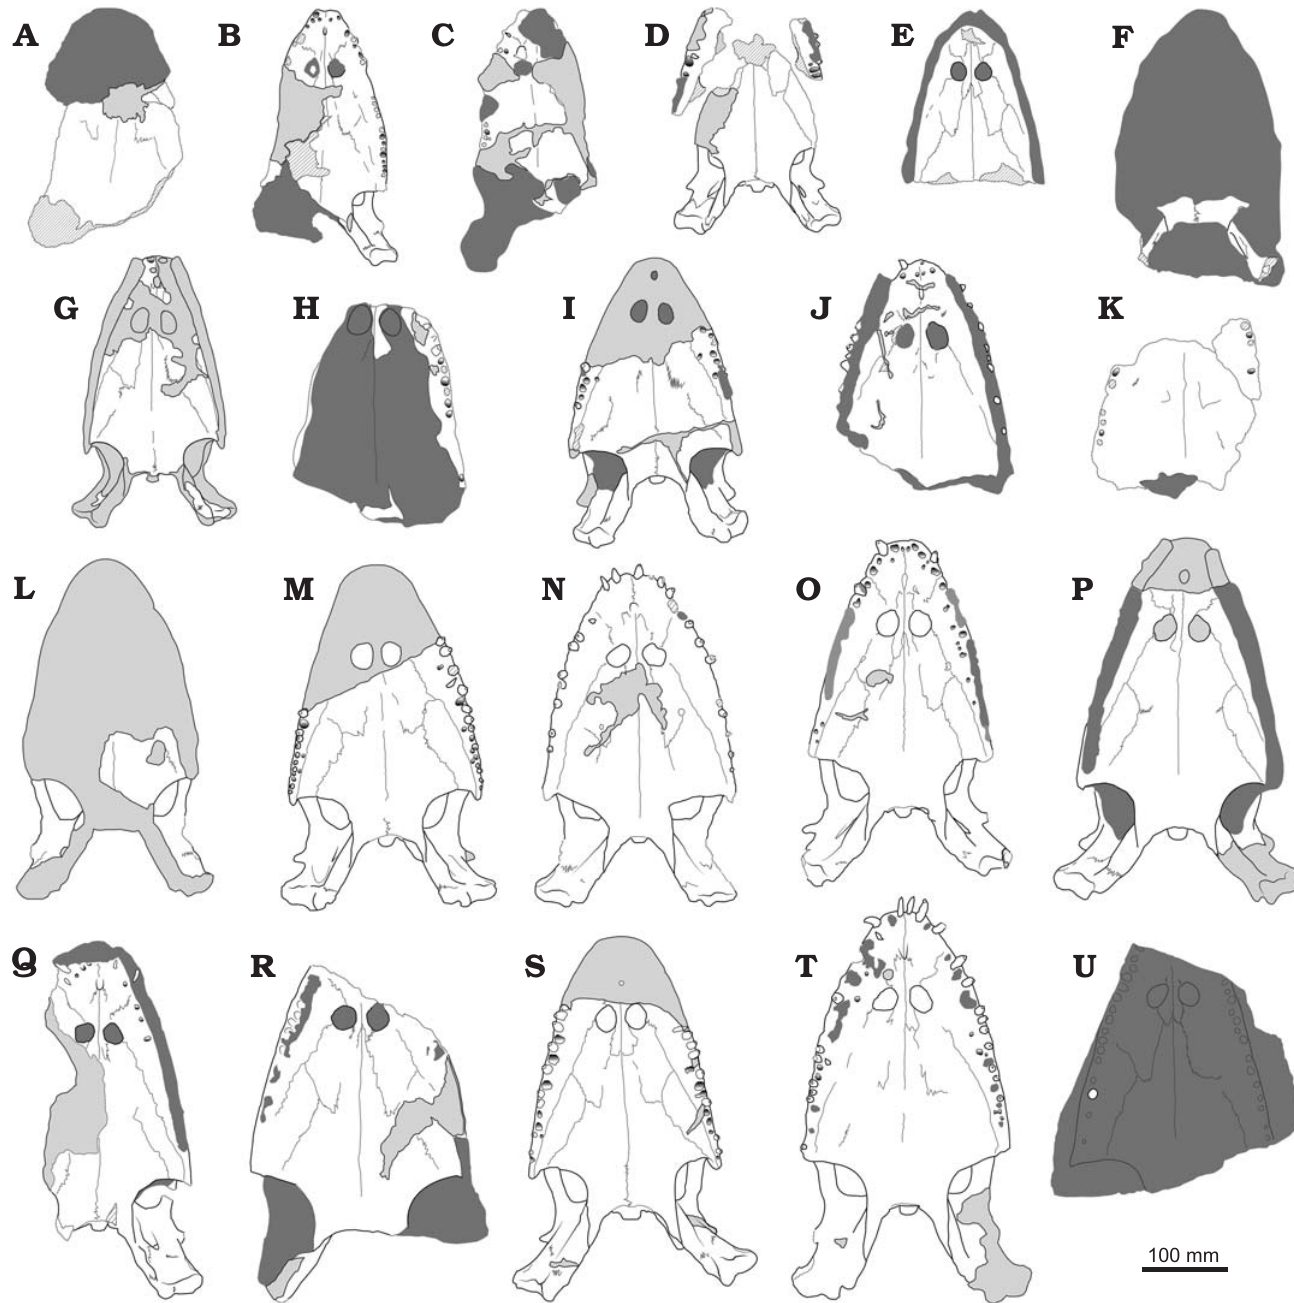
Fig. 4. Schematic interpretations of the skulls of simosaurid sauropterygian Simosaurus gaillardoti Meyer, 1842 from the Ladinian, Middle Triassic of northeastern France (A) and southwestern Germany (B–U), in ventral view. A . MNHN.F.AC. 9025. B . SMNS 18274. C . SMNS 16639. D . SMNS 16767. E . SMNS 18520. F . SMNS 16700 (holotype of “ Simosaurus guilielmi ” Meyer, 1852). G . SMNS 56288. H . SMNS 11364. I . SMNS 59366. J . SMNS 18550. K . SMNS 16735a. L . MHI 1366. M . SMNS 50714. N . GPIT/RE/09313. O . SMNS 10360. P . SMNS 16363. Q . SMNS 18637. R . MB.R. 52. S . SMNS 50715. T . MHI 1833. U . SMNS 11364b. Light grey, plaster; dark grey, matrix; grated areas, broken or altered bones; dashed lines, limits of broken bones; thin grey lines,